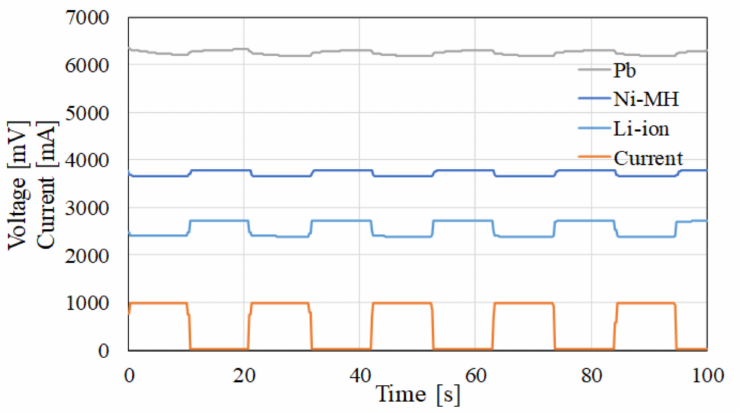
Figure 9. Voltage responses of three type of rechargeable battery based on pulse current discharging of 50 mHz frequency.